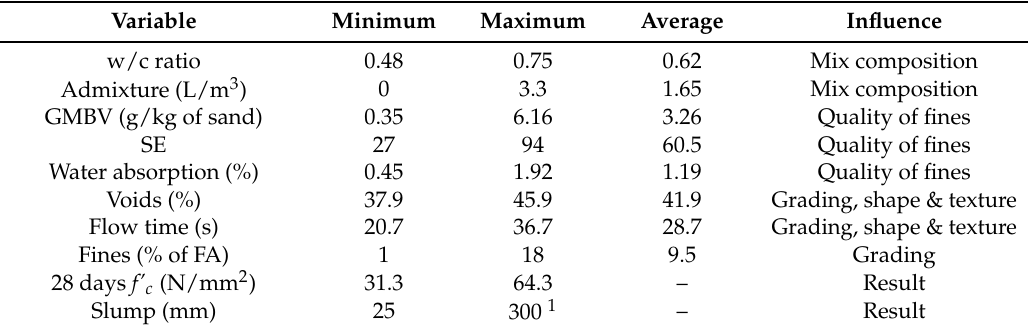
Table 6. Range of input and output variables and the parameter that they